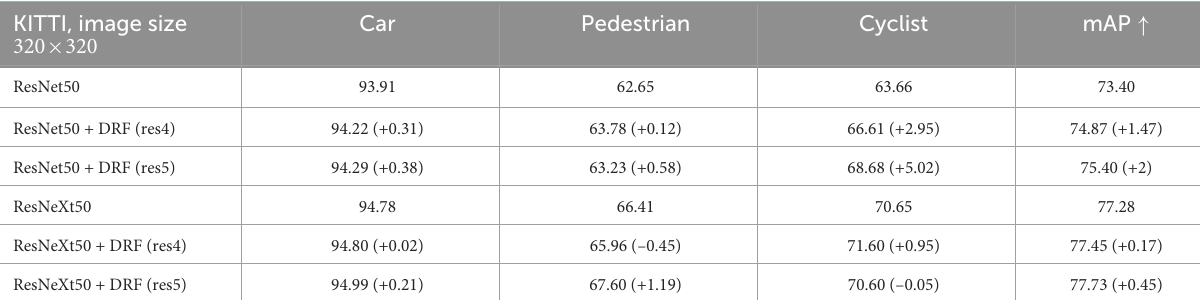
TABLE 3 Detection results on KITTI dataset by replacing the penultimate residual block of the last stage of Resnet50 and ResneXt50 backbone with the proposed M-DRF ( M = 8). KITTI, image size